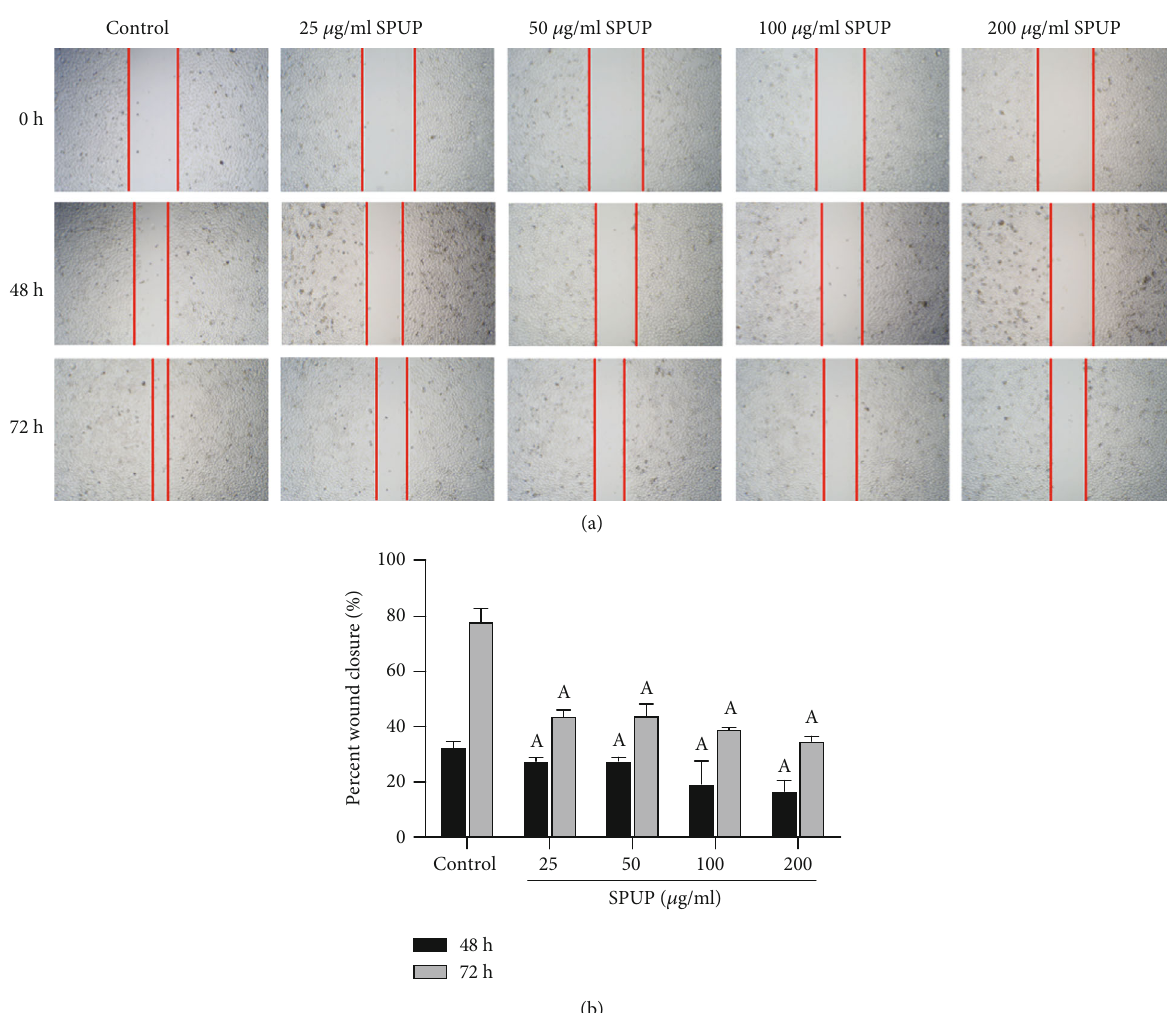
Figure 3: E ff ect of SPUP on the migration of DU145 cells. Compared with the control group, A: < 0.05.